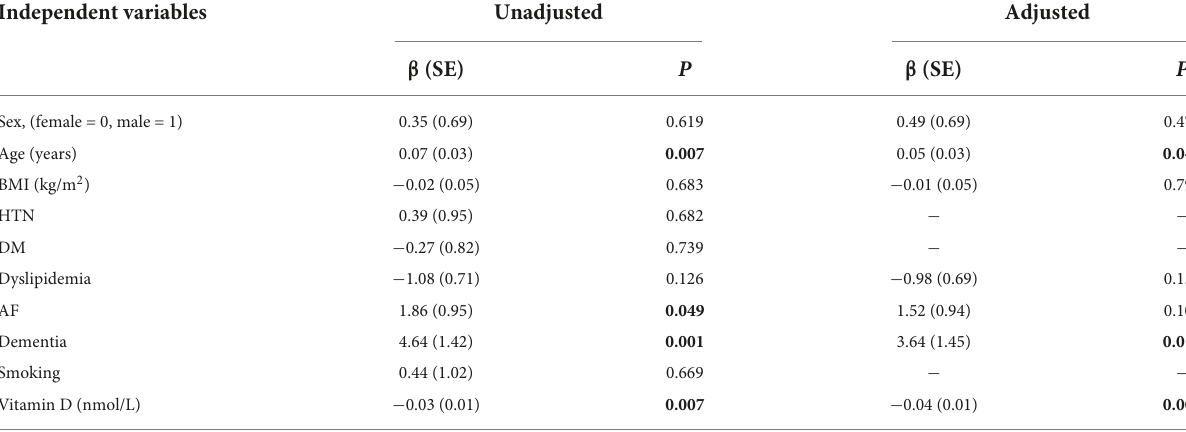
TABLE 3 Simple and multiple linear regression analysis for association of independent variables with the NIH Stroke score. Independent variables